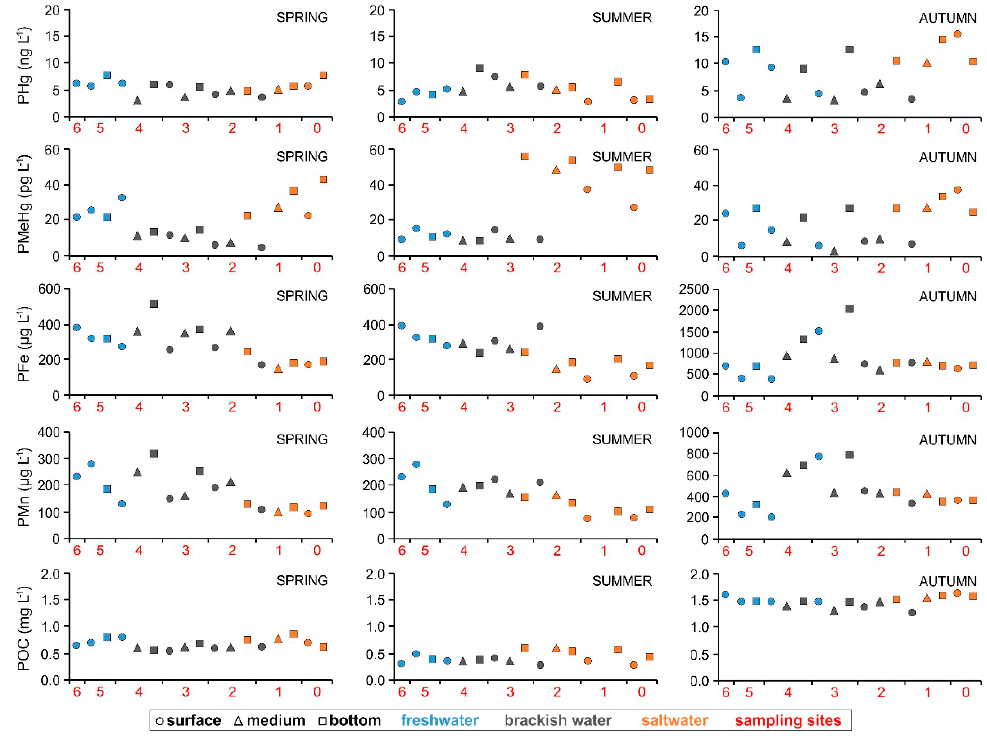
Figure 5. Distribution of PHg, PMeHg, PFe, PMn and POC in the water column from the upper sector of the estuary of the Nalón River to its mouth (from site 6 to site 0) under different seasonal conditions (spring, summer and autumn).